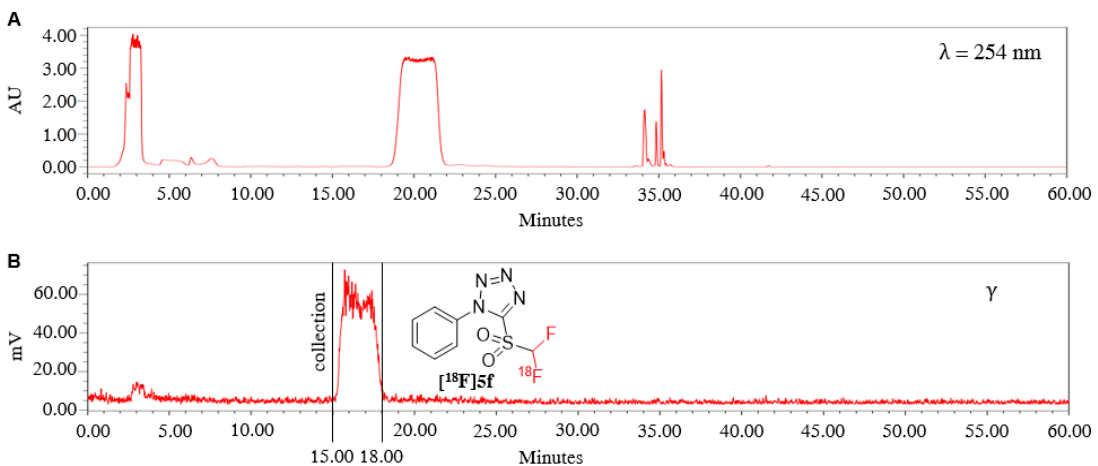
Figure 6. ( A ) UV-HPLC purification profile of the crude [ 18 F]5f . ( B ) Radio-HPLC purification profile of the crude [ 18 F]5f . Note: the appearance of broad flat-topped peaks in UV-HPLC chromatogram is derived from a saturation of the UV detector by the injecting crude product [ 18 F]5f .